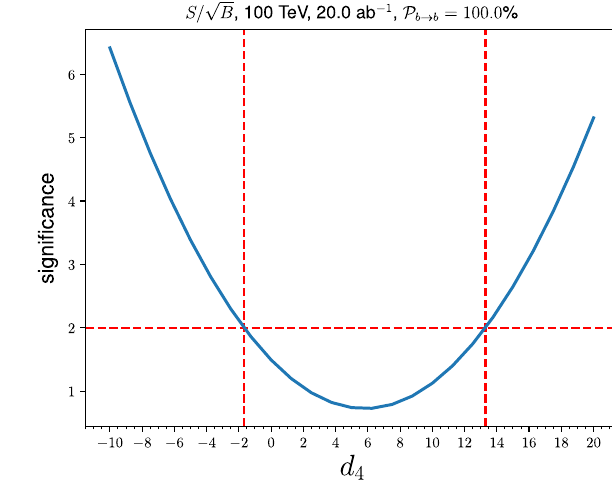
Fig. 6 The significance for our analysis of triple Higgs boson pro- duction in the ( b ¯ b )( b ¯ b )( b ¯ b ) final state with modified self-couplings ( λ 4 = λ SM ( 1 + d 4 ) and λ 3 = λ SM ( 1 + c 3 ) ) at the FCC-hh at 100 TeV. We have assumed an integrated luminosity of 20 ab − 1 and perfect b -tagging. The black star indicates the SM point